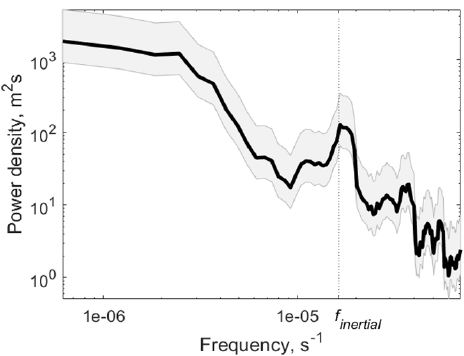
Figure 10. Spectral density of the hypoxia onset depth for 4–27 Jan- uary 2016. The 95% confidence interval is shown in gray.